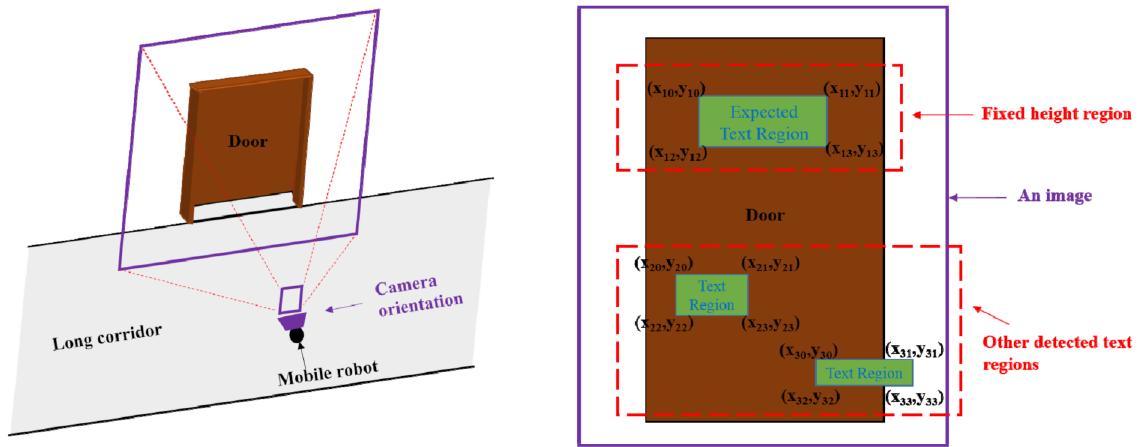
Figure 3. Text detection from the best position and